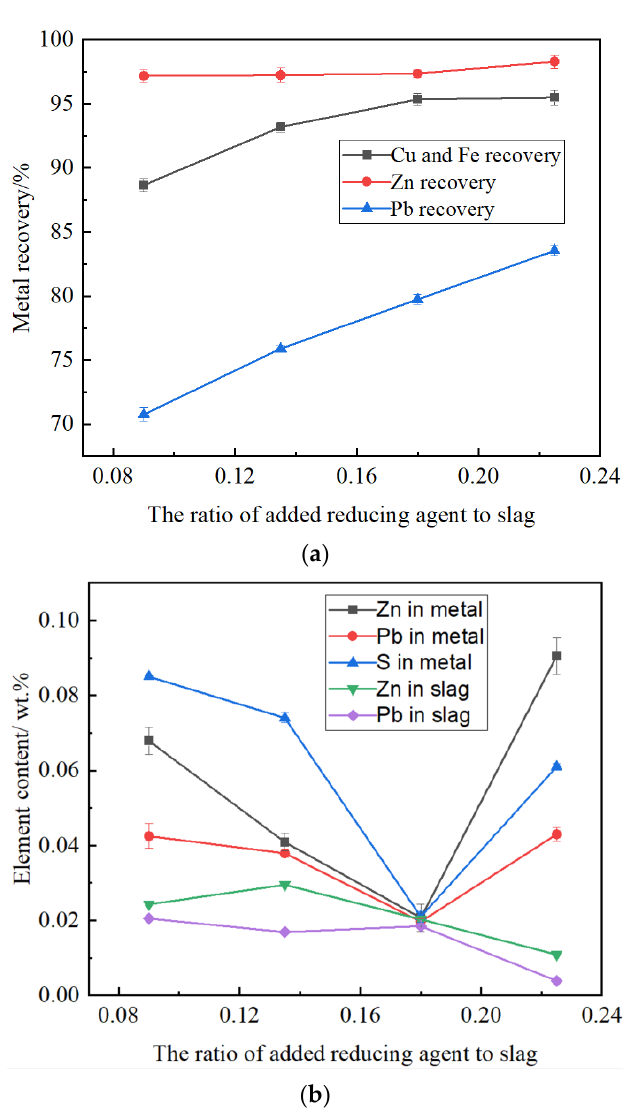
Figure 9. The effect of the addition of a reducing agent on the reduction of slag ( a ): metal recovery, ( b ): element content in metal and slag. ( b ): element content in metal and